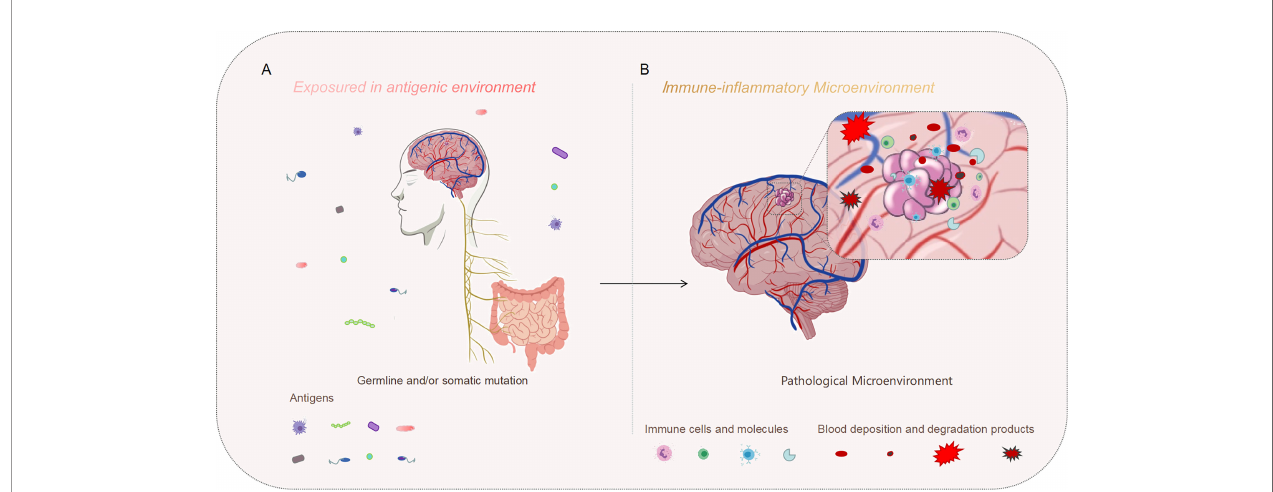
FIGURE 1 | Genetic mutation might be the initial motivation, and the in fl ammatory perturbation in the immune microenvironment may drive the progression of the disease. (A) On the macro level, our bodies are constantly exposed to an antigenic environment, which could be one of the synergistic agents leading to CCM formation. (B) On the micro level, CCM lesions exist in the immune microenvironment. The immune microenvironment characterized by in fl ammation may aggravate the development of the typical pathology, meanwhile, repeated microbleeds could also exacerbate the in fl ammatory in fi ltration of this pathological